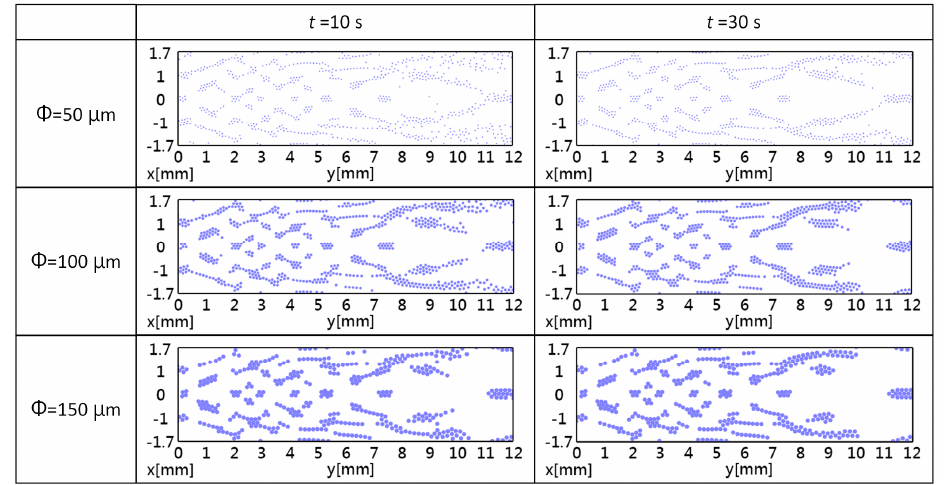
Figure 5. The two-dimensional simulation results of the micro-particle distribution of Fresnel lens acoustic tweezers, where Φ is the particle diameter and t is the simulated time.